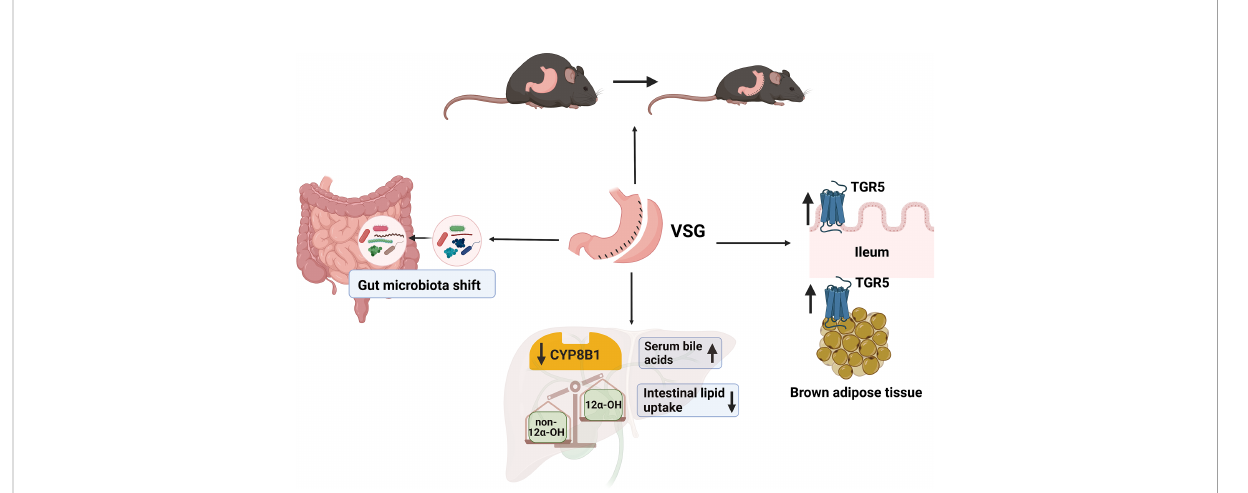
FIGURE 3 A summary of what we know about VSG, bile acids, and gut microbiota. After VSG in mice, bile acid receptor TGR5 in the ileum and brown adipose tissue is activated, and subsequently leads to increased energy expenditure and decrease in body weight (109). Total serum bile acids is increased after VSG, and intestinal lipid uptake is decreased. The downregulation of CYP8B1 after VSG leads to a decrease the ratio of 12 a -OH and non-12 a -OH bile acids. Finally, the gut microbiota pro fi le is shifted after VSG; but the precise relationship between VSG and gut microbiota needs further investigation. (Created with